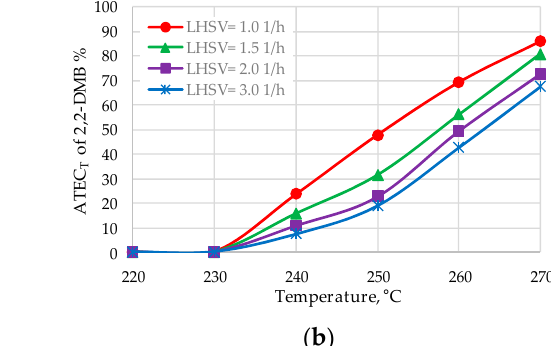
Figure 7. ATEC of 2-MB ( a ) and 2,2-DMB ( b ) as a function of temperature and LHSV (catalyst: Pt/H- Mordenite/Al 2 O 3 , feedstock: “B”).